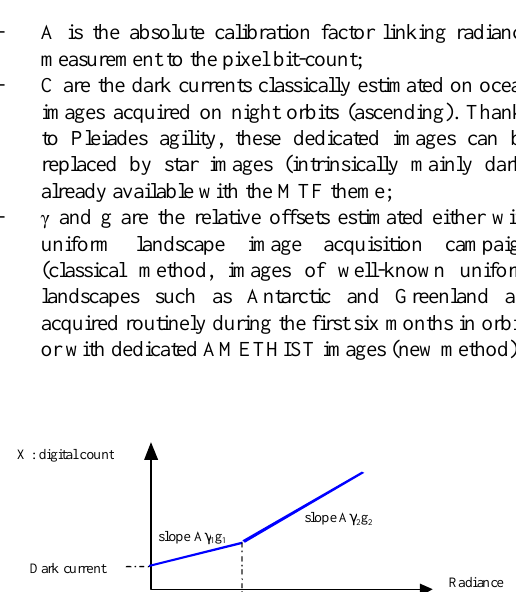
Figure 5. Restored PA Pleiades-HR image of Melbourne acquired at 4 bits/pixels and simulated at lower bit